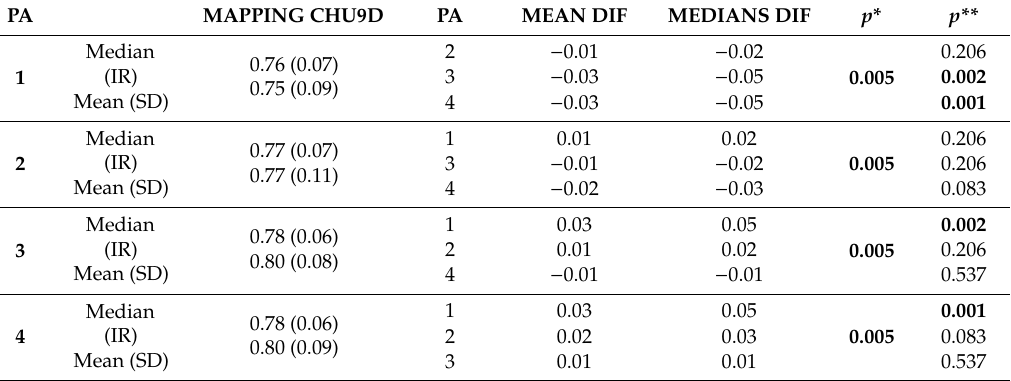
Table 3. Comparison of HRQoL, calculated by MAPPING CHU9D, according to